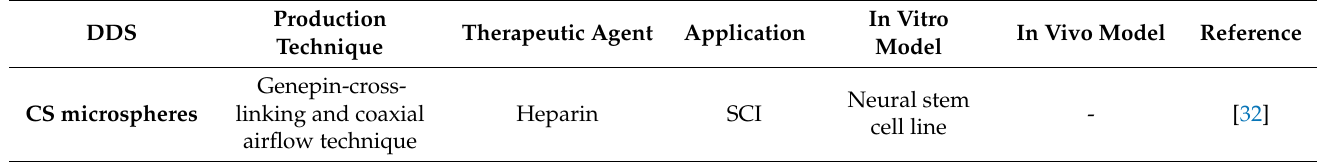
Table 1. Summary of CS- and CS-association-based DDSs for SCI and PNI application. DDS descrip- tion, production technique, therapeutic agent delivered, and in vitro and in vivo models exploited for efficacy assessment are